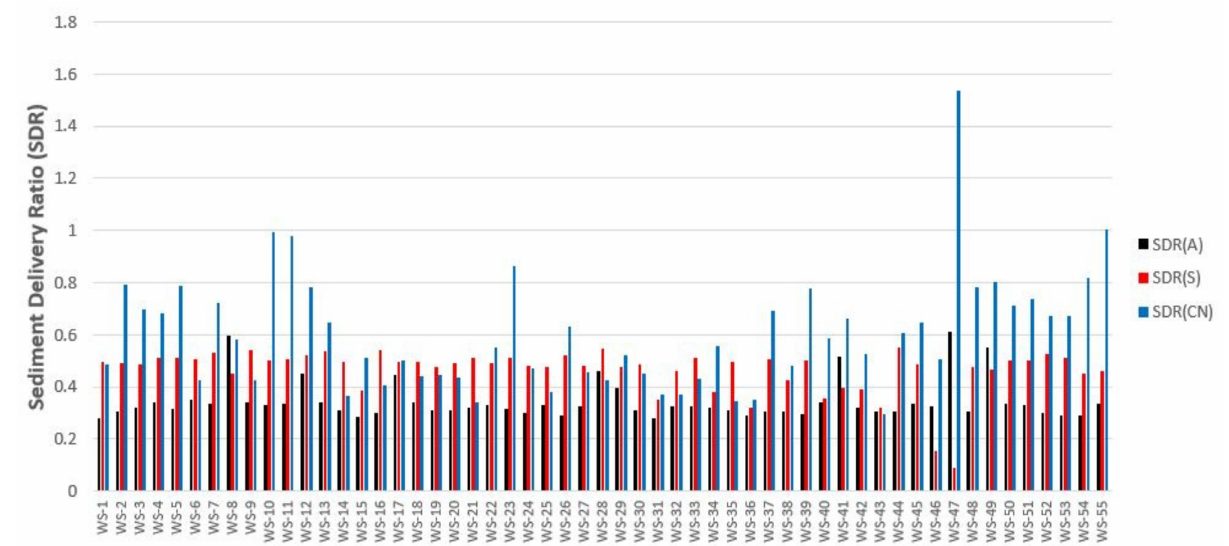
Figure 10. Mean Sediment delivery ratio in each